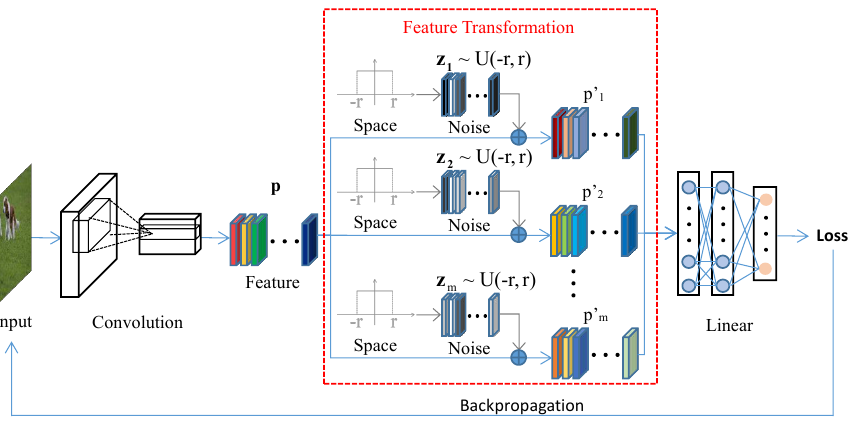
Figure 1. Illustration of the proposed FTM. The feature transformation shown in the illustration is the Strategy I. The random noise vectors z i sampled from the uniform distribution are added to the feature p . The average loss of the transformed features is calculated to update the input